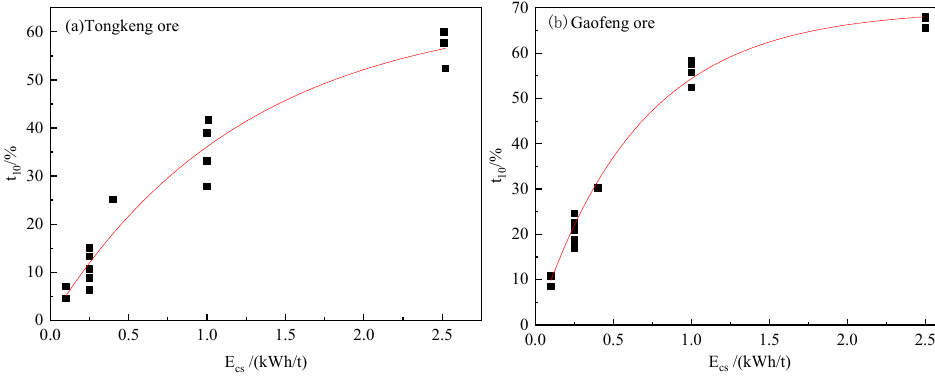
Figure 4. Fitting curve of t 10 and specific crushing energy E cs of Tongkeng ore and Gaofeng ore. By fitting the test data with Equation (2) and combining with Figure 4, the parameters of Tongkeng ore and Gaofeng ore can be obtained. The specific parameter values are shown in Table 6. Table 6. The specific parameter values of Tongkeng ore and Gaofeng ore. Type of Ore